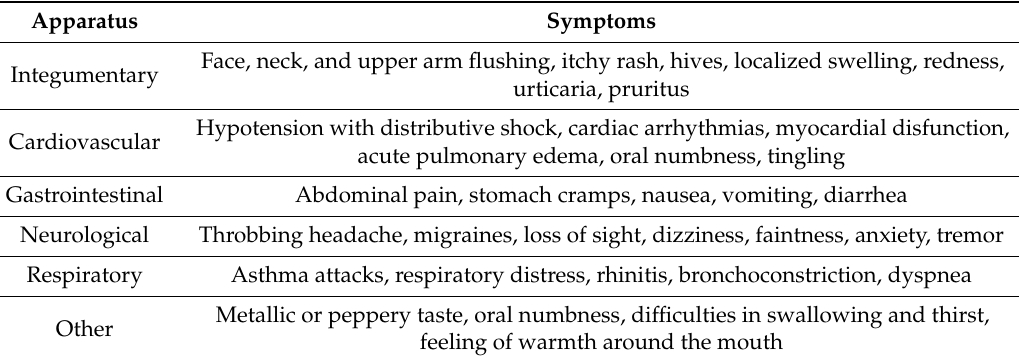
Table 3. Symptoms of scombroid